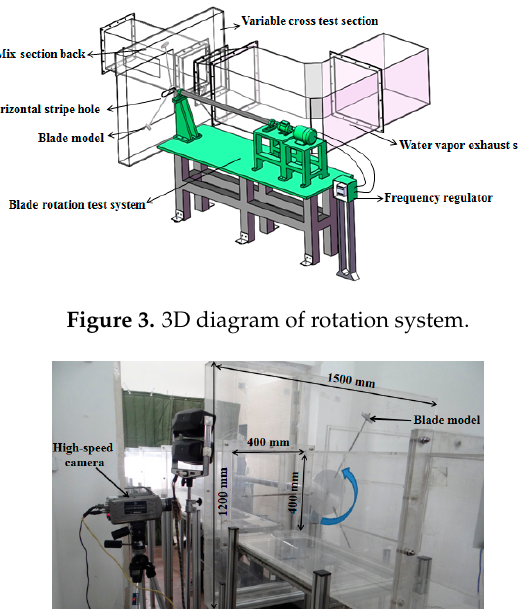
Figure 2. Schematic diagram of icing wind tunnel experiment system (IWTES).